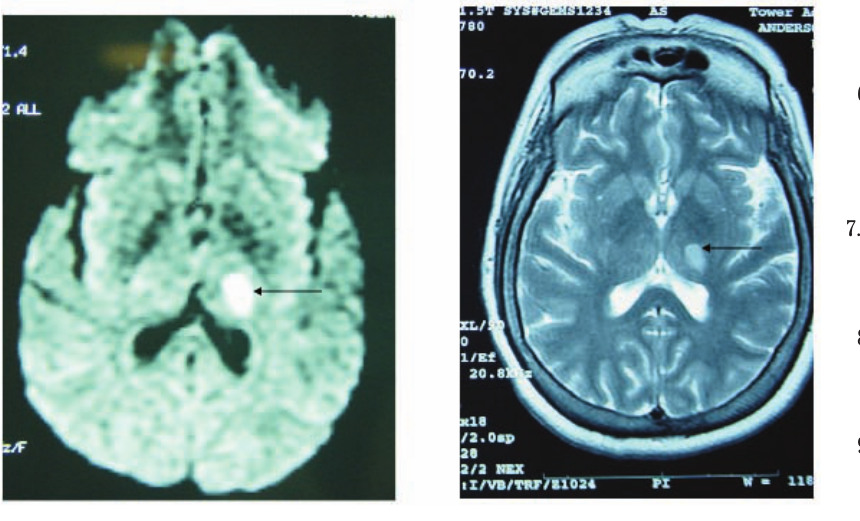
Figure 1. Left thalamic infarct depicted on diffusion weighted and T2 weighted magnetic resonance scan